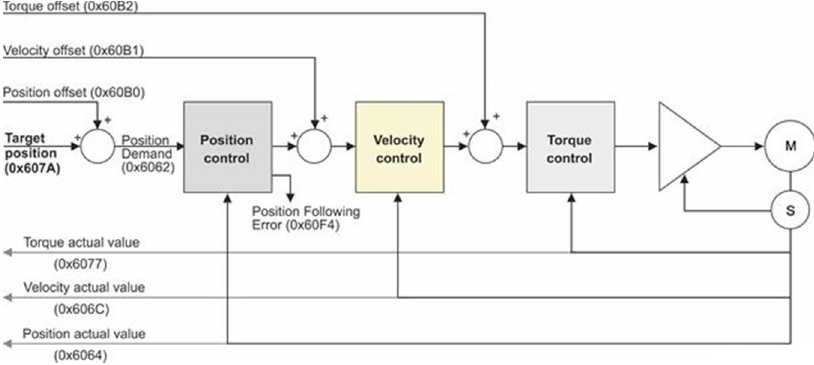
Figure 9. Overall control scheme of each motor.